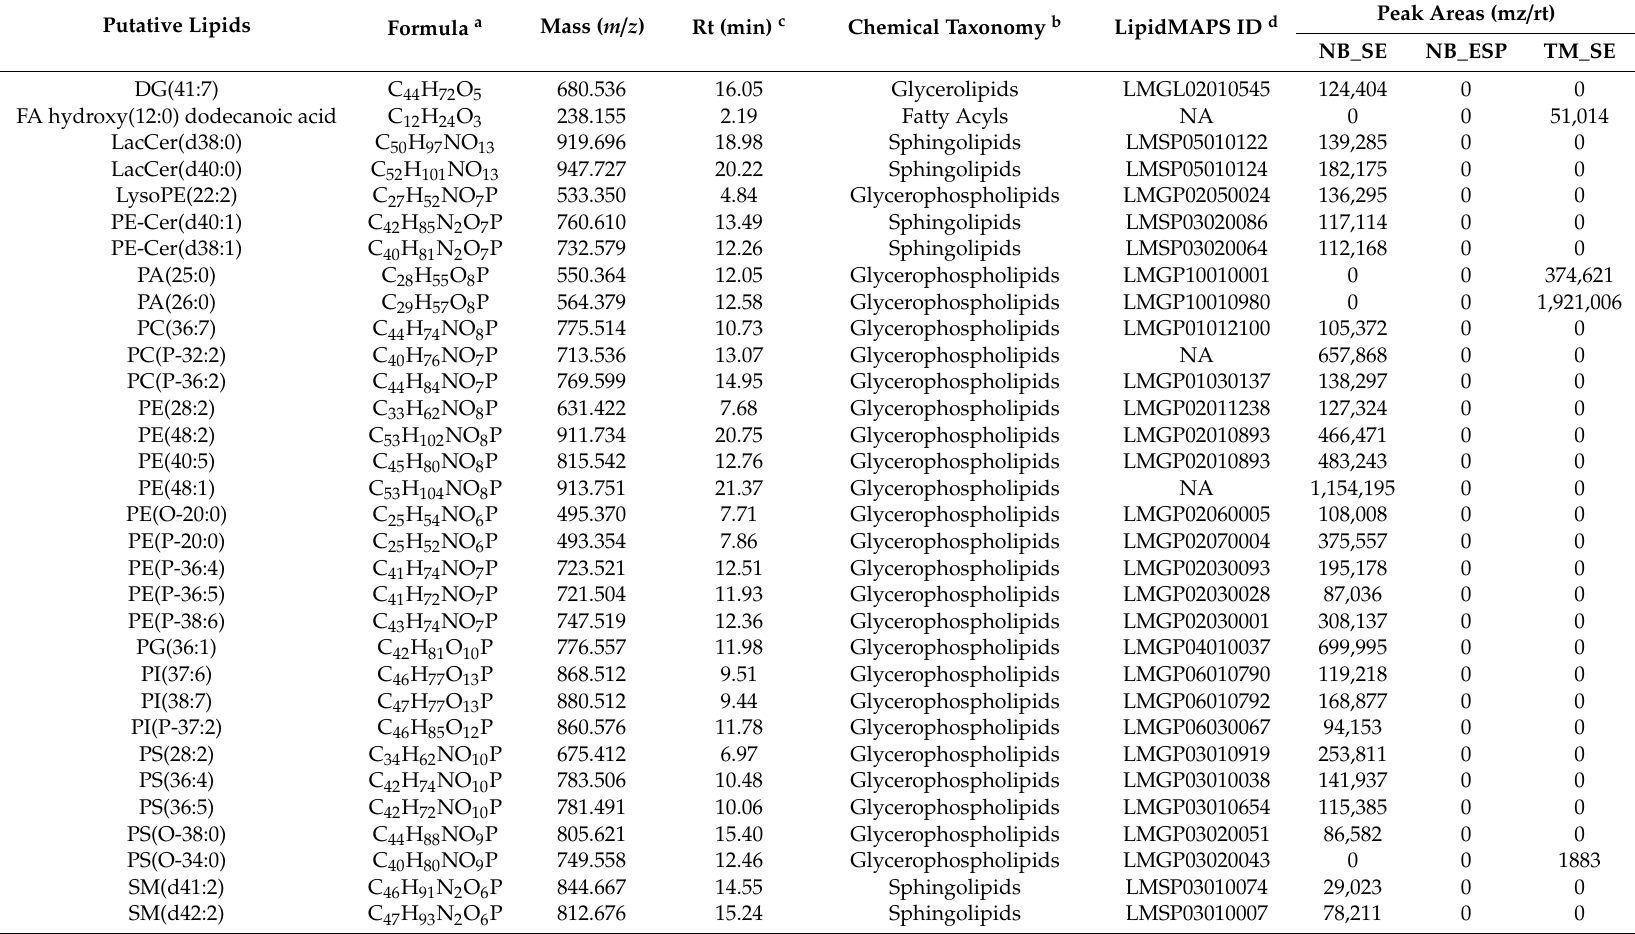
Table 2. Putative lipids unique to infective stages of N. brasiliensis (L3) and T. muris (embryonated eggs). Putative